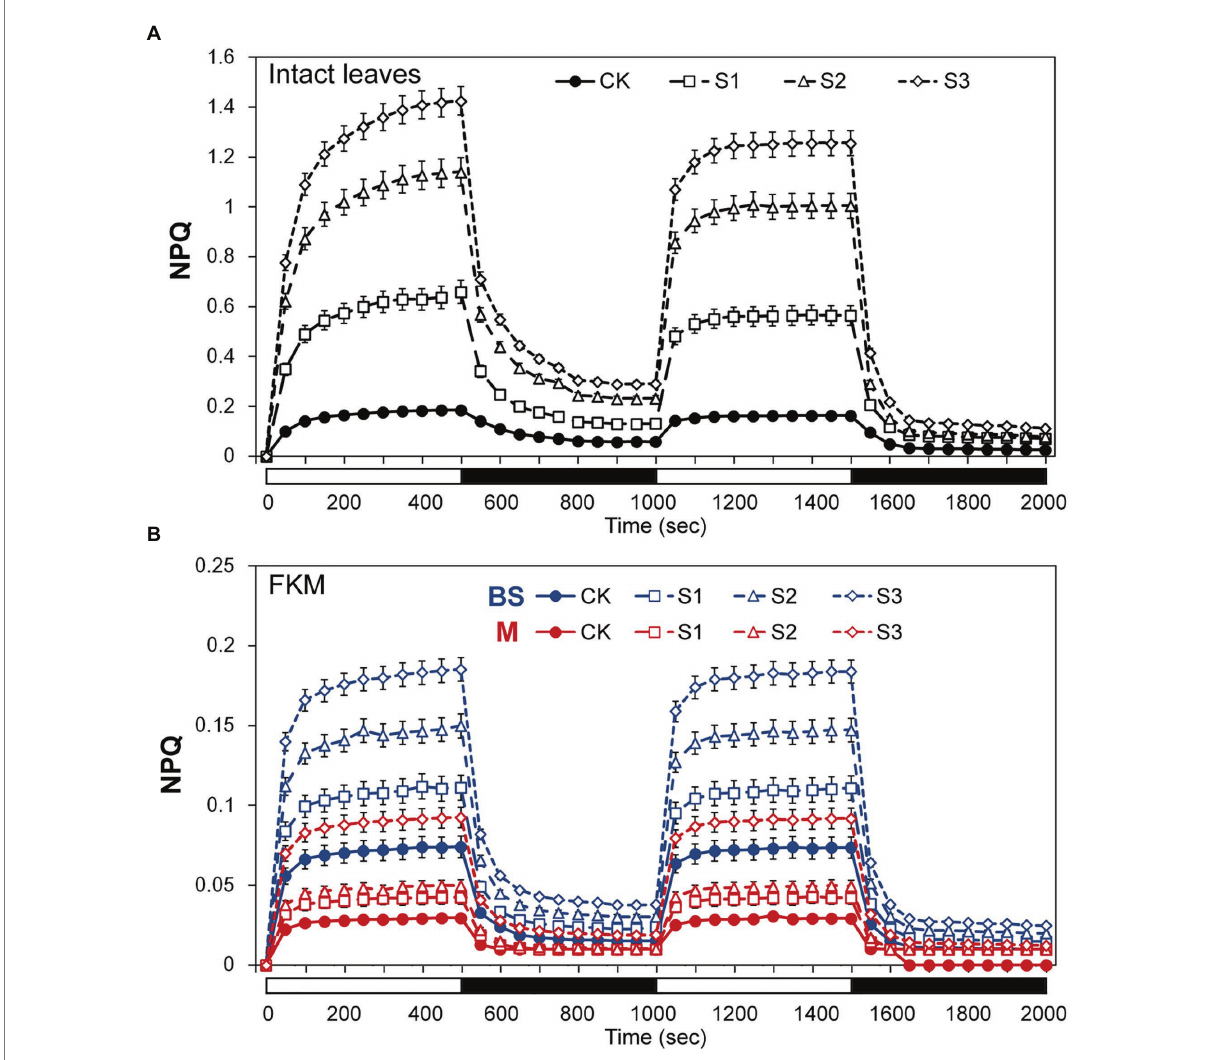
FIGURE 4 Assays of non-photochemical quenching (NPQ) kinetics under drought stress. (A) Measurement of NPQ kinetics in intact maize leaves. (B) Measurement of NPQ kinetics in M and BS chloroplasts of maize leaves. The two consecutive periods of illumination with 1,500 mol m − 2 s − 1 for 500 s with a 500 s period of darkness in between, as indicated by the white (light on) and black (dark) bars at the bottom of figure. CK, well-watered control; S1, mild drought stress; S2, moderate drought stress; and S3, severe drought stress. Vertical bars represent SD of the mean ( n =